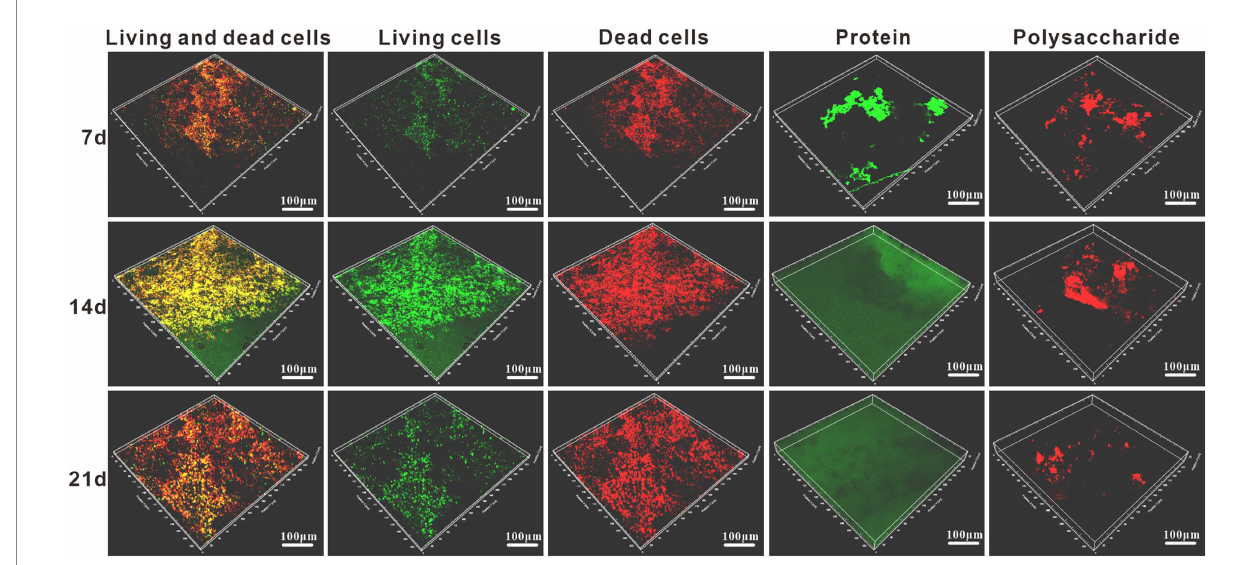
FIGURE 5 Staining schematic of the live/dead bacteria and protein/polysaccharide in Alcaligenes sp. media after different periods of